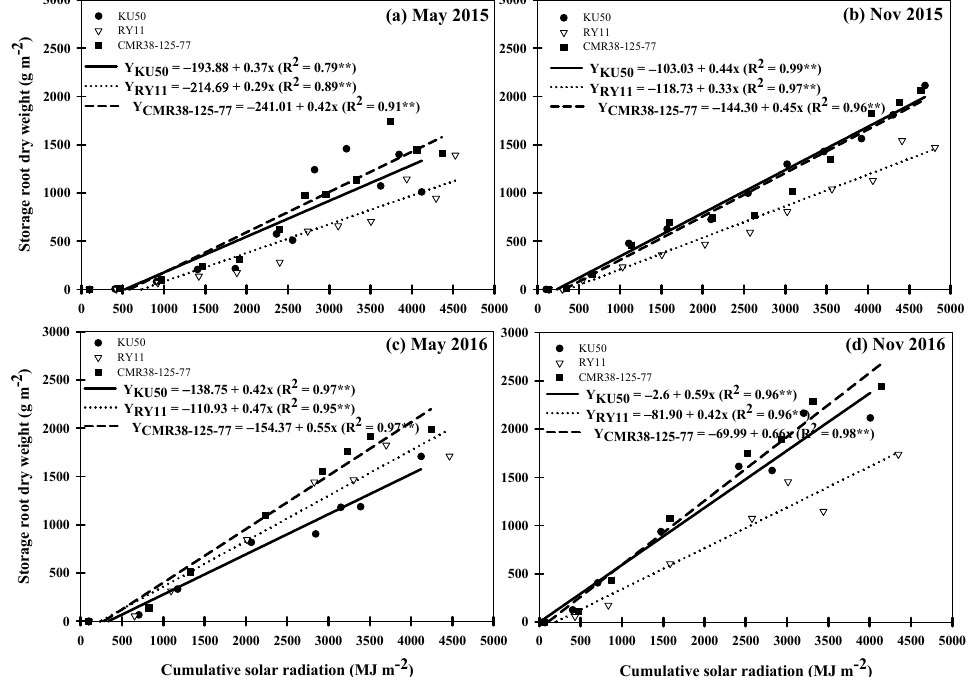
Figure 6. Regression analysis for storage root dry weight and cumulative solar radiation of 3 cassava genotypes planted in May and November 2015 ( a , b ) and 2016 ( c , d ). ** = significant at p < 0.01 probability levels.